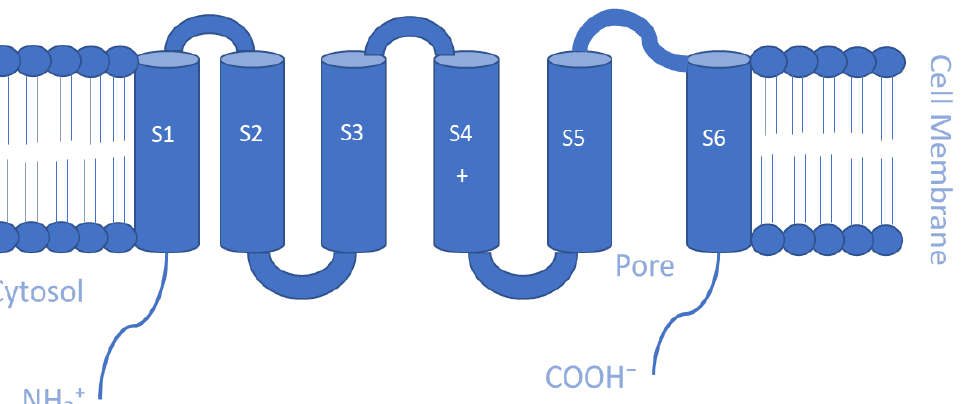
Figure 1. Schematic representation of the transmembrane (TM) topology of Kv channel α -subunits containing six TM segments (S1–S6), a pore region formed by S5 and S6 segments and cytosolic N- and C-termini.